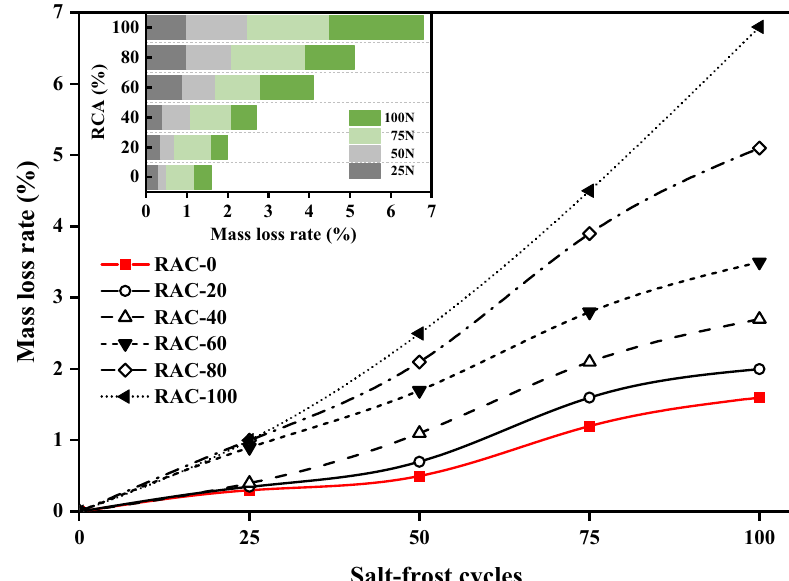
Figure 6: The MLR of concrete after salt - frost cycles.